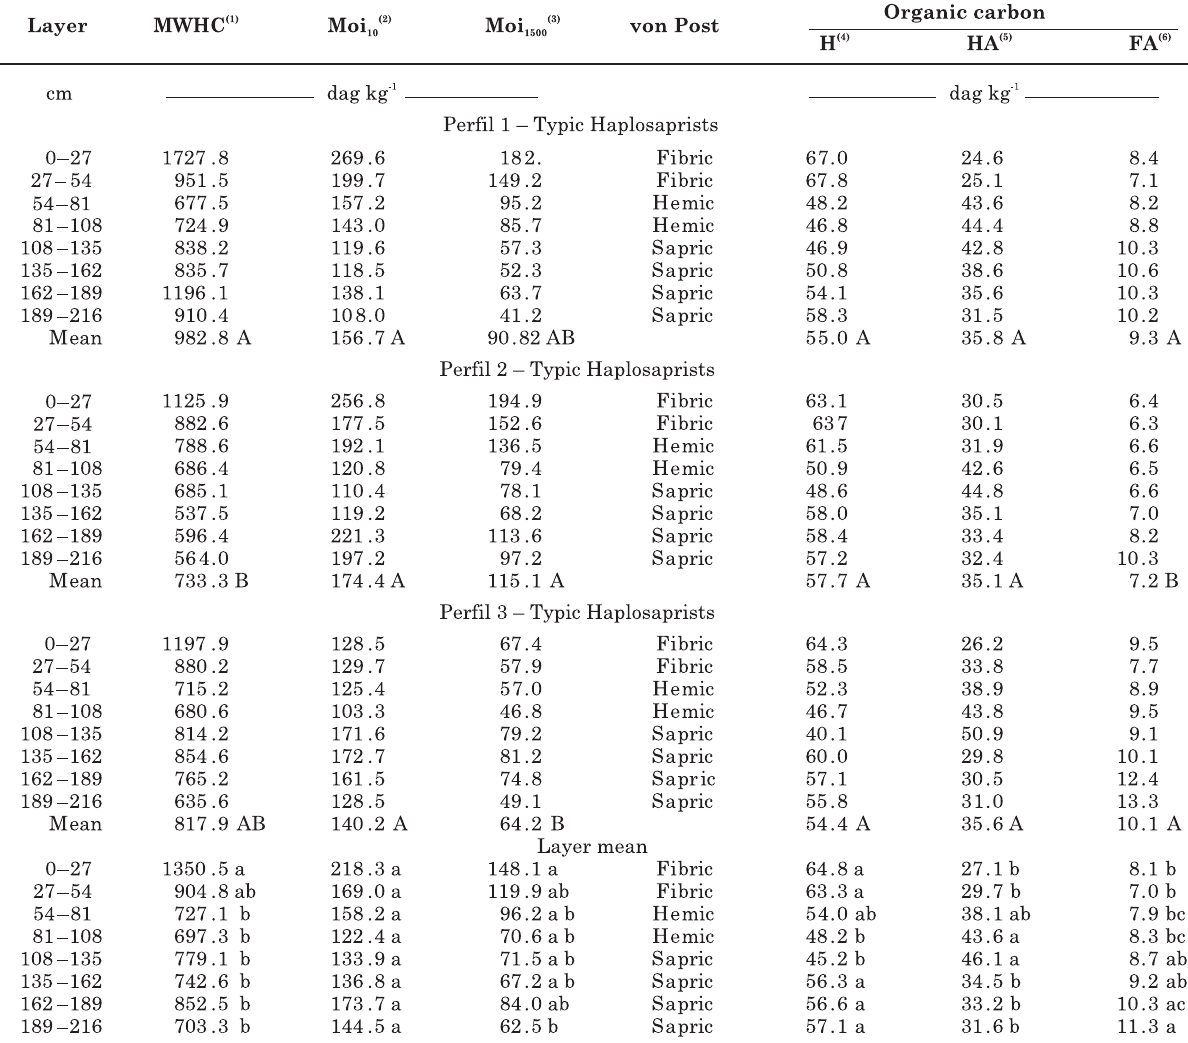
Table 4. Hydric parameters, decomposition stage of organic matter (von Post), and content of C-humic substances in three peatland profiles in the conservation unit